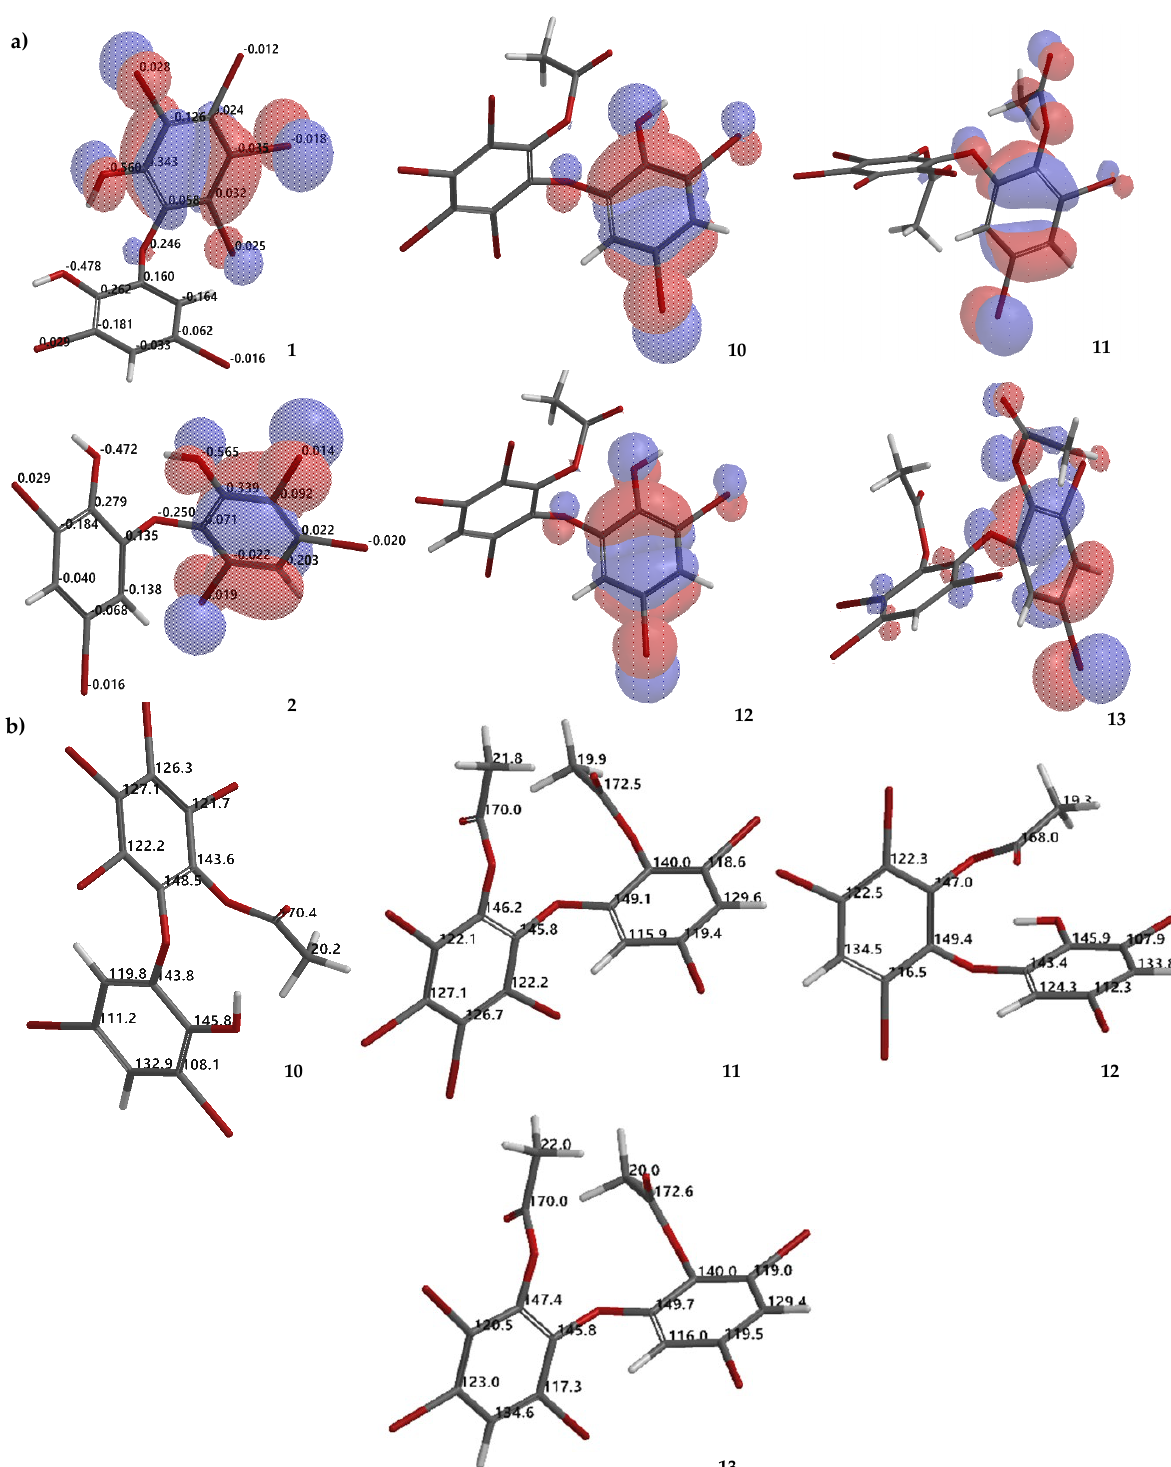
Figure 6. Molecular orbital analysis (HOMO) of 1 , 2 , 10 – 13 calculated using DFT ωB97X -D/6–311 + G(2d,p) along with analysis of electrostatic charges of 1 and 2 ( a ). Proposed calculated 13 C NMR chemical shifts of 10 – 13 using the NMR chemical shift calculation protocol ( b ).